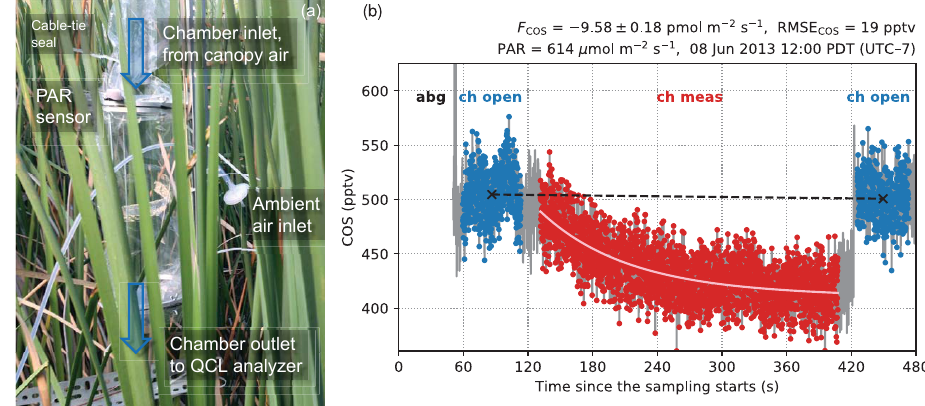
Figure 1. (a) A schematic diagram of the leaf chamber. (b) A typical sampling period on the leaf chamber illustrated with COS concentration measurements. The first minute is for auto-background spectral correction (abg) using N 2 gas. The sampling system then switches to the chamber line with the ventilation fan turned on (ch open) for 1min. Then the ventilation fan is turned off for 5mins to measure flux signals in the chamber (ch meas), and after that is turned on again for 1min (ch open). The fitted curve for concentration changes is shown in light pink. The black dashed line represents the zero-flux baseline correction to account for the drift in the measured ambient